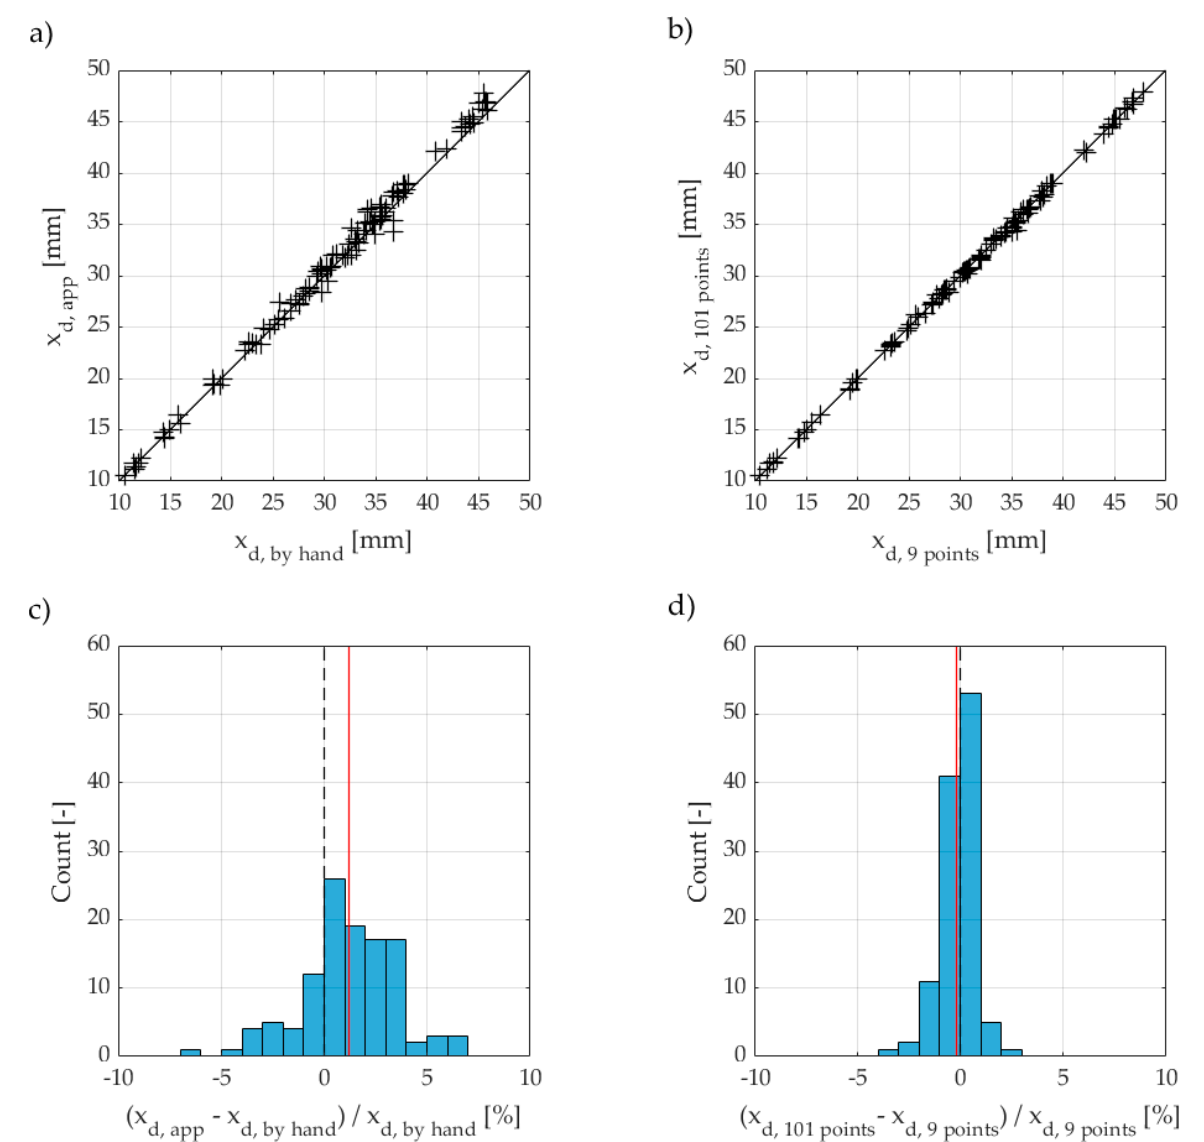
Figure 4. Direct comparison of the penetration depths x d determined with the RCM app or a caliper ( a ) at 101 or 9 points with the app ( b ) and relative comparison of the results ( c , d ). The mean deviation of the relative results is indicated by a vertical red line.